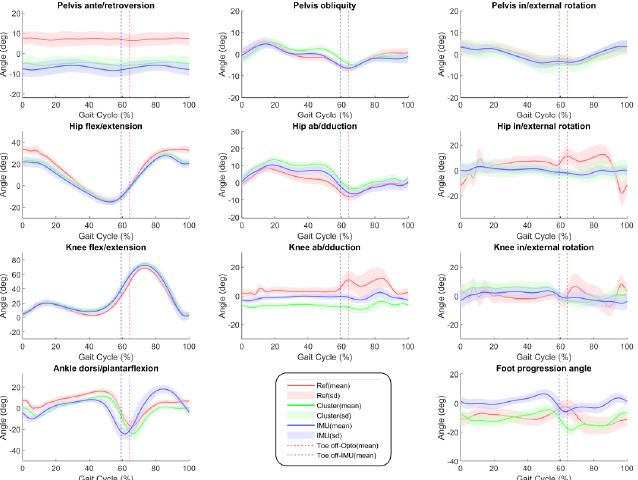
Figure 5. Mean kinematic curves ( ± standard deviation ‘sd’) of all participants’ right sides. In red: the reference (‘Ref’) kinematics from anatomical markers; in green: the kinematics obtained from the clusters; in blue: the kinematics obtained from the IMUs. The dashed lines correspond to the mean toe off events detected, in red: detected from the anatomical markers with the optoelectronic (‘Opto’) system; in blue: detected from the IMUs located on the feet.